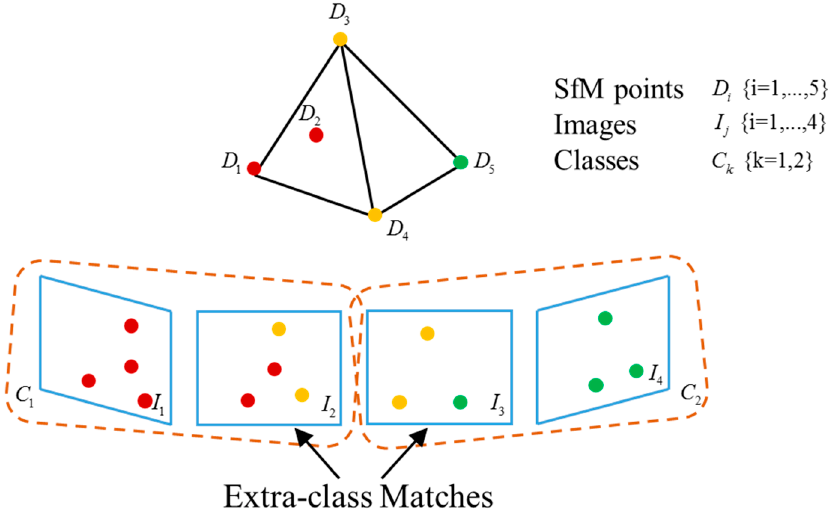
Figure 2. An example of matched point selection. D 1 − D 4 are cloud points recovered from class one, which are marked in red. D 3 − D 5 are cloud points recovered from class two, which are marked in green. D 3 and D 4 are matched points that can be recovered from both classes, which are marked in yellow. The matched points are selected by conducting extra-class matches between images I 2 and I 3 . The matched feature points between images are chosen as the matched points between classes.